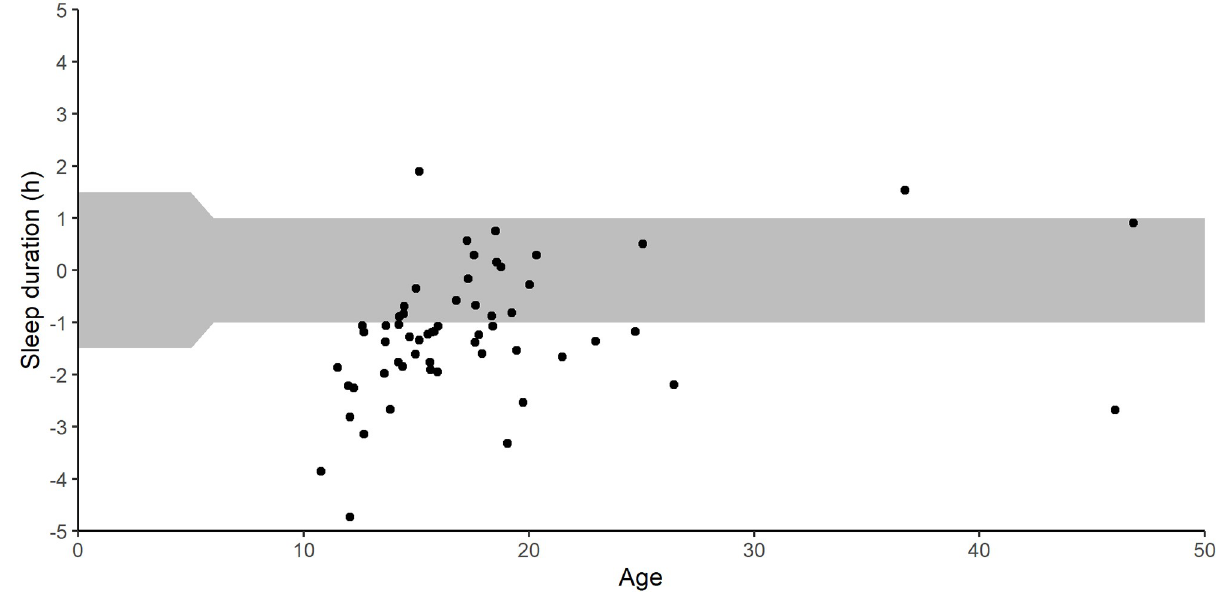
Fig 1. Scatter plot with deviation (in hours) from recommendations of sleep duration on the y-axis and age on the x-axis. The grey area displays the recommended interval of